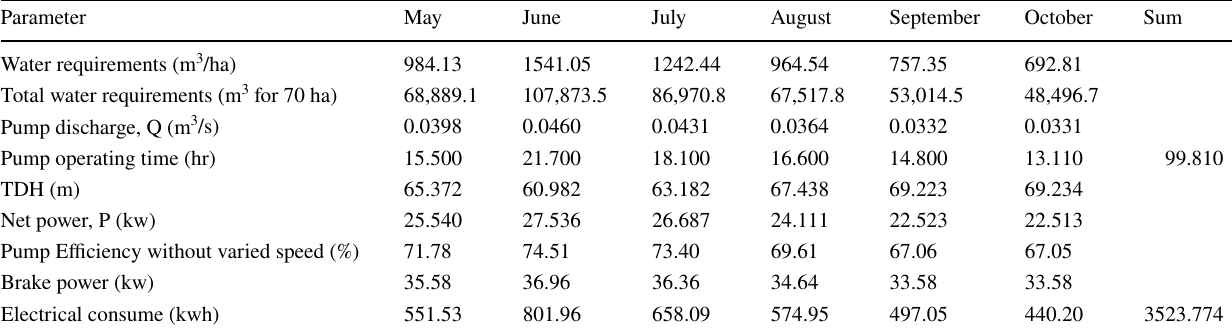
Table 4 Calculation of efficiency, brake power and electrical consumption of sprinkler irrigation system in the current design conditions (con- stant speed pump)